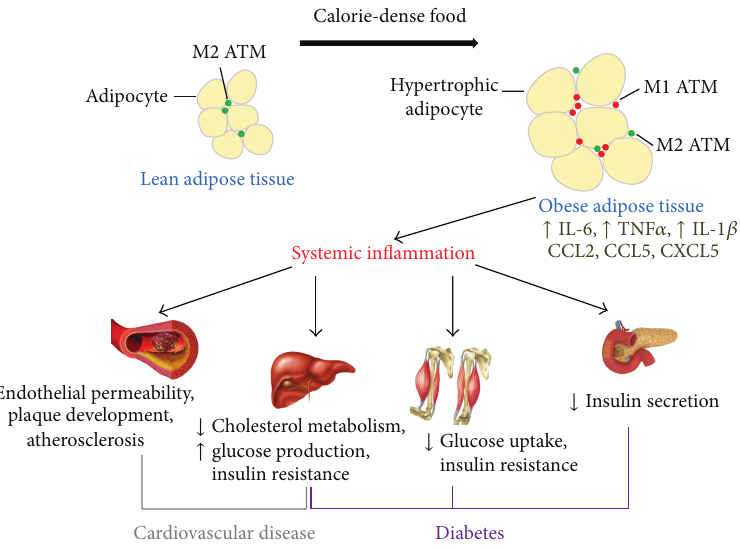
Figure 1: Obesity contributes to development of diabetes and cardiovascular disease. Adipose tissue is composed of two main cell types, adipocytes and stromovascular mononuclear cells (i.e., resident leukocytes). Adipose tissue macrophages (ATMs) are the most frequent leukocyte subtype in fat tissues. Normal adipose tissue is populated with the alternatively activated M2 ATMs. Persistent or frequent consumption of calorie-dense food results in obesity that is associated with increased adiposity which includes adipose tissue hypertrophy and influx of proinflammatory monocytes that mature to classically activated M1 ATMs. Obesity induces production of proinflammatory cytokines (i.e., IL-6, TNF 𝛼 , and IL-1 𝛽 ) and several chemokines including CCL2, CCL5, and CXCL5 among others by adipocytes and immune cells trigger adipose tissue inflammation, which when prolonged progresses to systemic inflammation that affects (i) vasculature increasing permeability of endothelium, thereby triggering plaque development and cardiovascular disease; (ii) anabolic actions of insulin and insulin signaling in metabolic tissues including liver and skeletal muscle, causing insulin resistance that manifests as impaired glucose disposal in muscle and altered cholesterol and glucose metabolism in the liver, which in turn triggers hyperinsulinemia, hyperglycemia, and hyperlipidemia that all contribute to type 2 diabetes and cardiovascular disease; and (iii) pancreas, decreasing insulin secretion that leads to hyperglycemia, which is a hallmark of